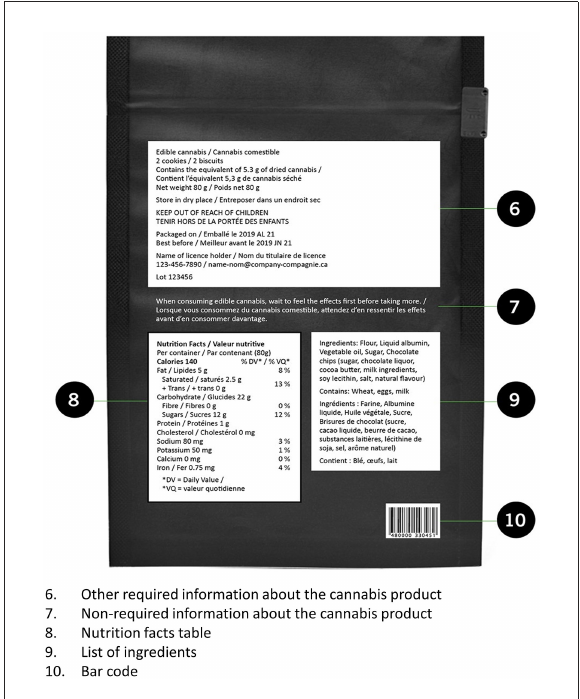
FIGURE2 The posterior side of cannabis packaging in Canada. Source: ©All rights reserved. Packaging and Labelling Requirements. Health Canada, modified 2019. Adapted and reproduced with permission from the Minister of Health,